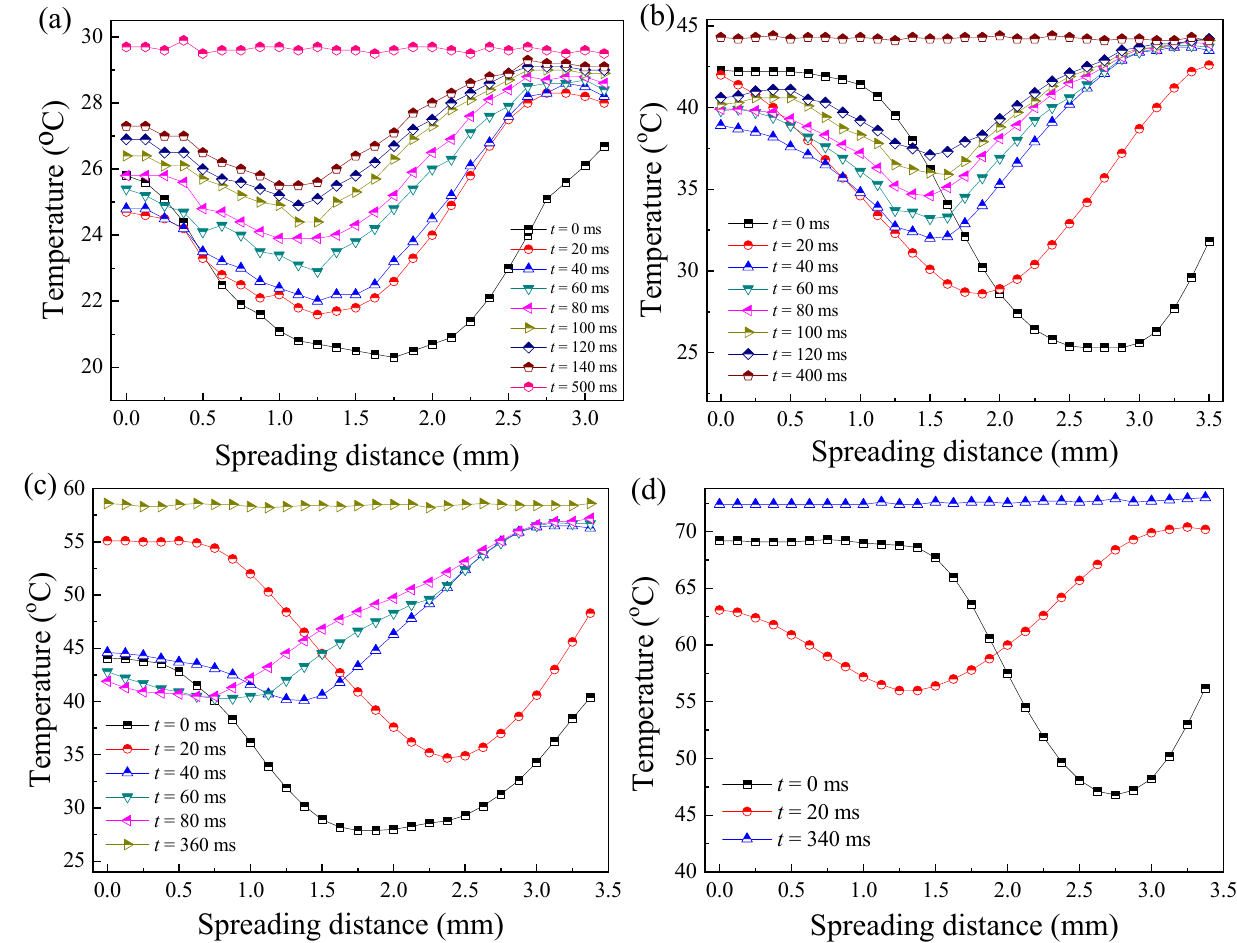
Figure 9. Radial temperature distributions of the spreading droplet on superhydrophilic surface for ( a ) W e = 7.6, T w = 30.0 °C, ( b ) W e = 7.6, T w = 44.0 °C, ( c ) W e = 7.6, T w = 58.0 °C, ( d ) W e = 7.6, T w = 72.5 °C.